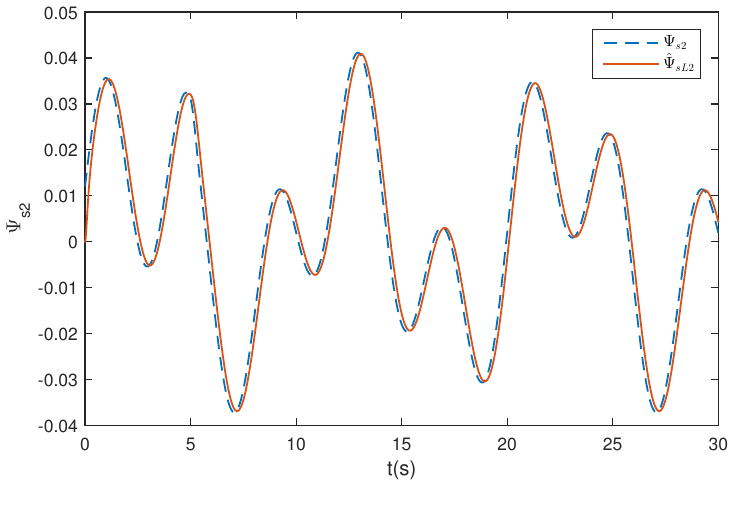
Figure 16. Estimation of Ψ s 2 using LESO.